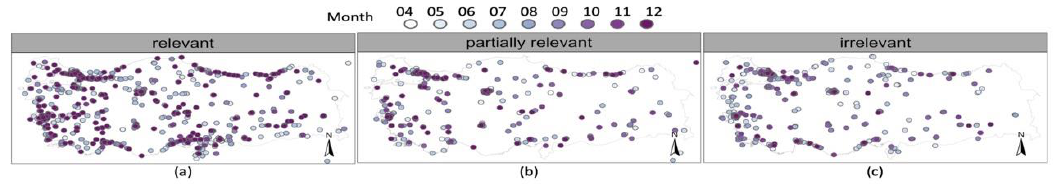
Figure 8. The labelled pre-filtered spatial data ( a ) RL; ( b ) PR; ( c )